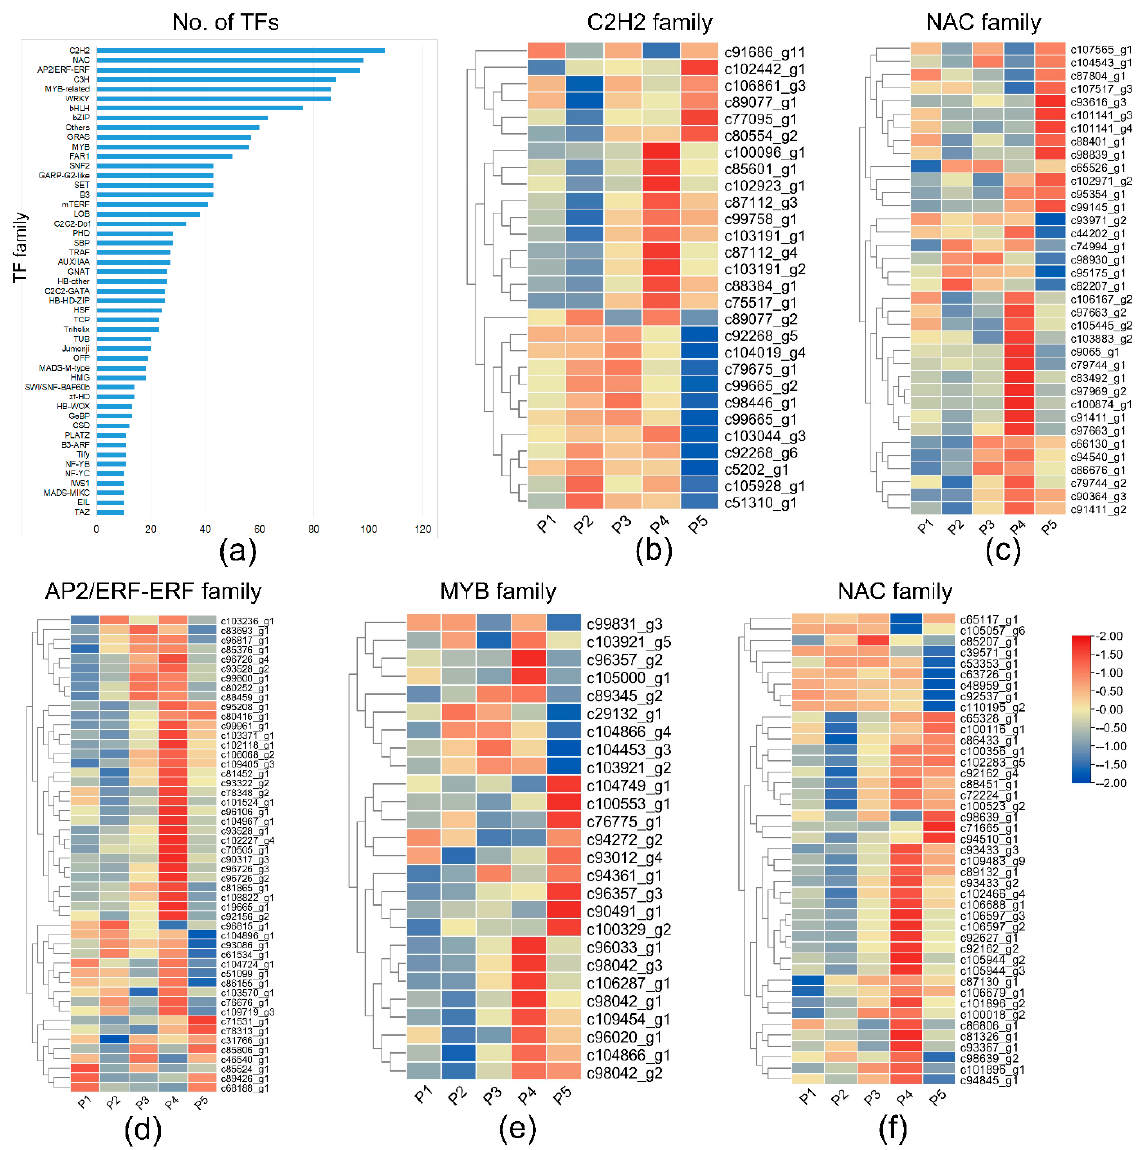
Figure 6. The statistics and abundance of transcription factor families (TFs): ( a ) forty − eight TF families with more than 10 identified unigenes; ( b – f ) comparison of P4 and P5 showing the differentially expressed TFs in the C2H2, NAC, AP2/ERF-ERF, MYB-related, and WRKY families.